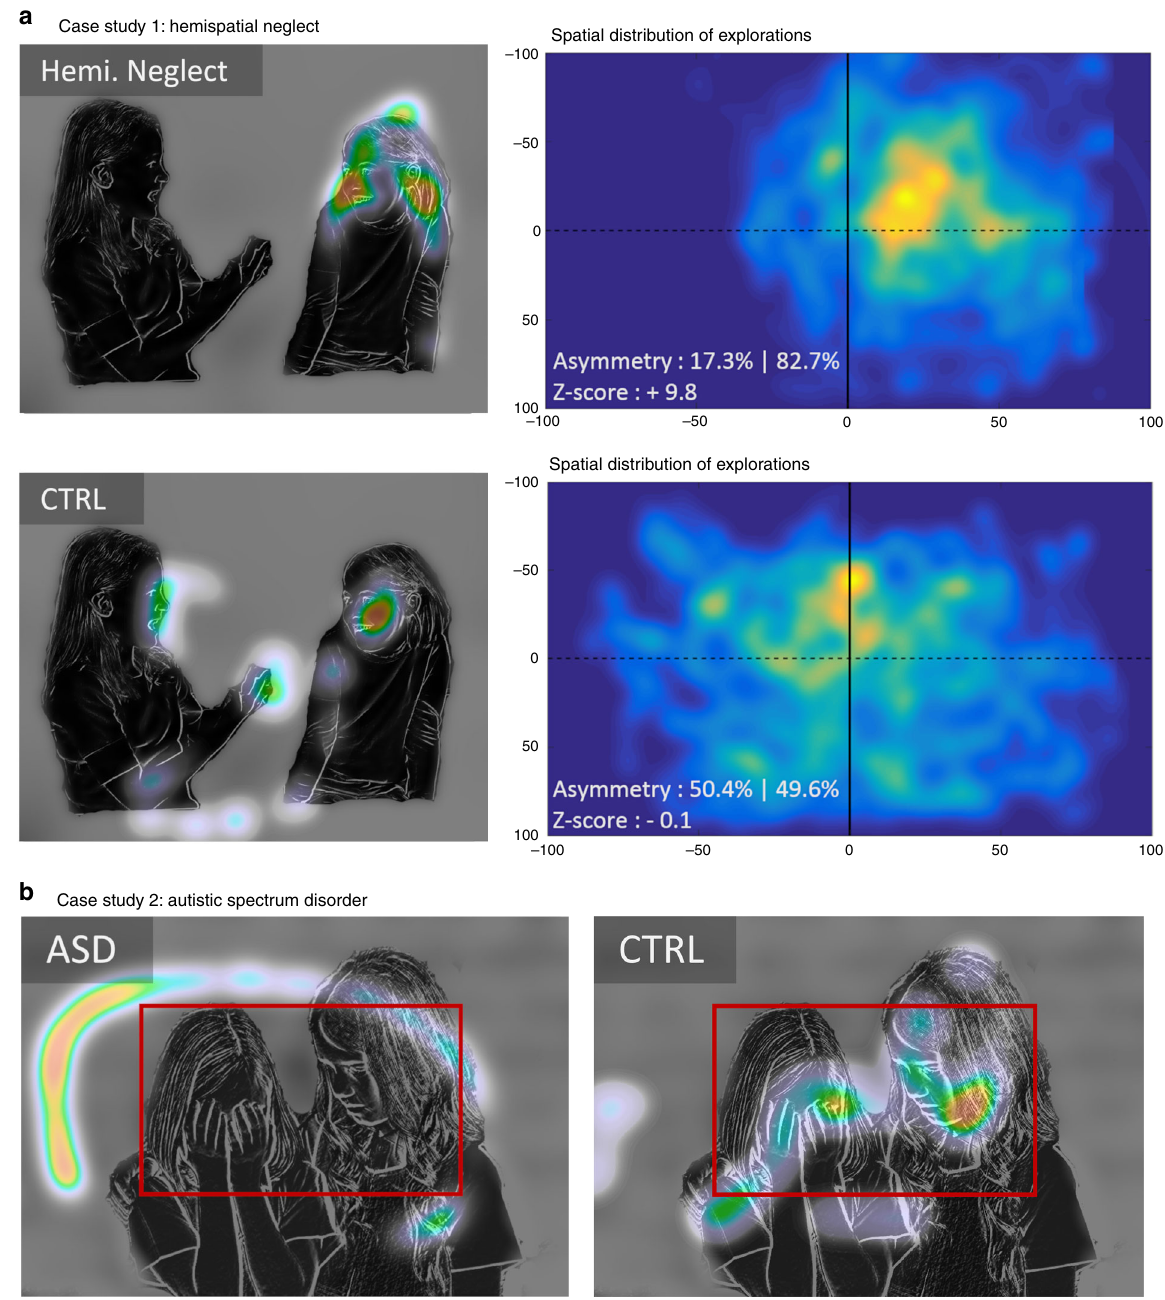
Fig. 4 Atypical exploration behaviors recorded using digit-tracking. a Example of image exploration by a patient suffering from hemispatial neglect (Hemi. Neglect) due to right-parietal lobe damage following stroke and a control subject. The right panels represent the average spatial distribution of the explorations recorded for 32 images in a single examination session. The spatial attention bias can be precisely quanti fi ed: for the control subject, 49.6% of their exploration is on the right side of the display (corresponding to a Z -score of − 0.1, centile 45, according to a reference population, N = 22), whereas for the patient, 82.7% of the exploration has been recorded on the right side of the display (corresponding to a Z -score of 9.8, centile>99.999). b Exploration of an image with social content by a 14-year- old non-verbal autistic child compared to a neurotypical control subject. The patient adopts an exploration strategy which avoids human faces (red frame), whereas these are the most explored scene elements in the control population. Please note that original faces have been modi fi ed to hide individuals ’